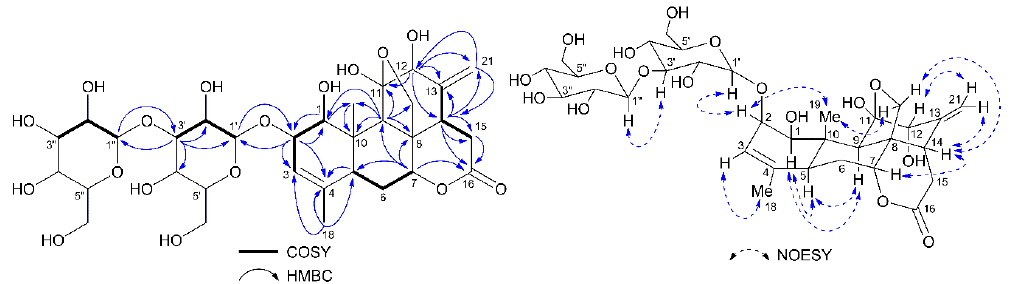
Figure 3. Selected HMBC (arrows), 1 H- 1 H COSY (bold lines) and key NOESY (dashed arrows) correlations of compound 2 .